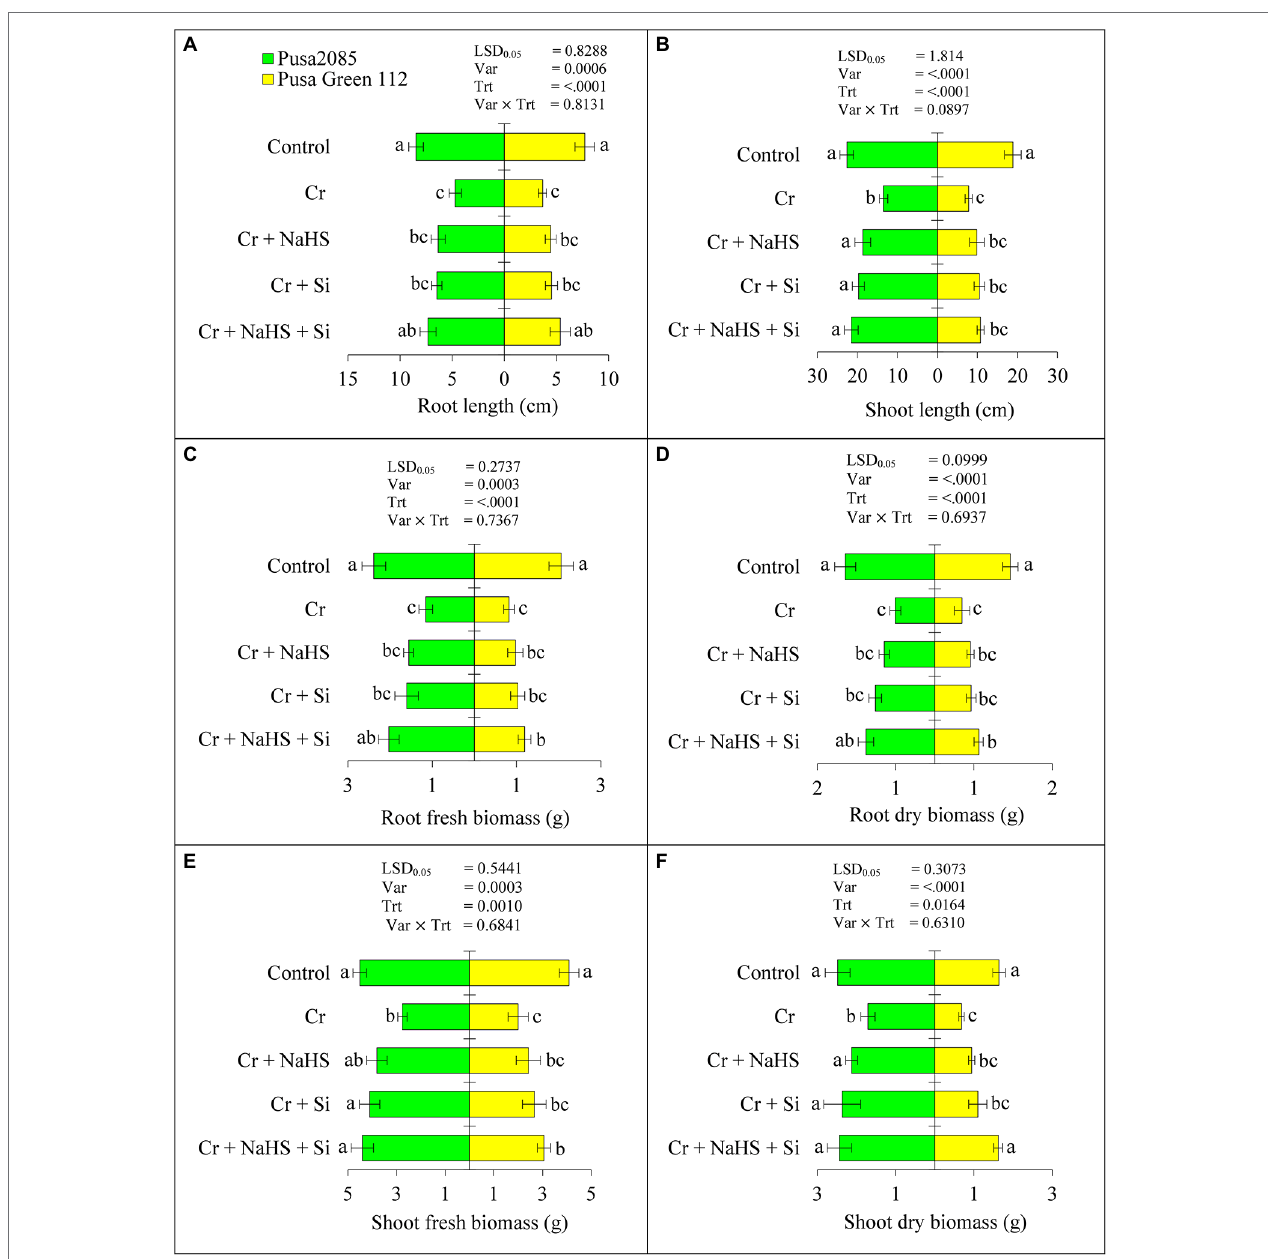
FIGURE 1 | Effect of NaHS, Si, and NaHS + Si treatments on (A) root length (RL)-root length (cm), (B) shoot length (SL)-shoot length (cm), (C) RFB-root fresh biomass (g), (D) RDW-root dry biomass (g), (E) SFW-shoot fresh biomass (g), and (F) SDW-shoot dry biomass (g) of both chickpea plants grown during Cr VI stress. Data are presented as mean ± SE ( n = 5), and different bar letters are indicated statistically differences ( p < 0.05) as tested by the least significant difference